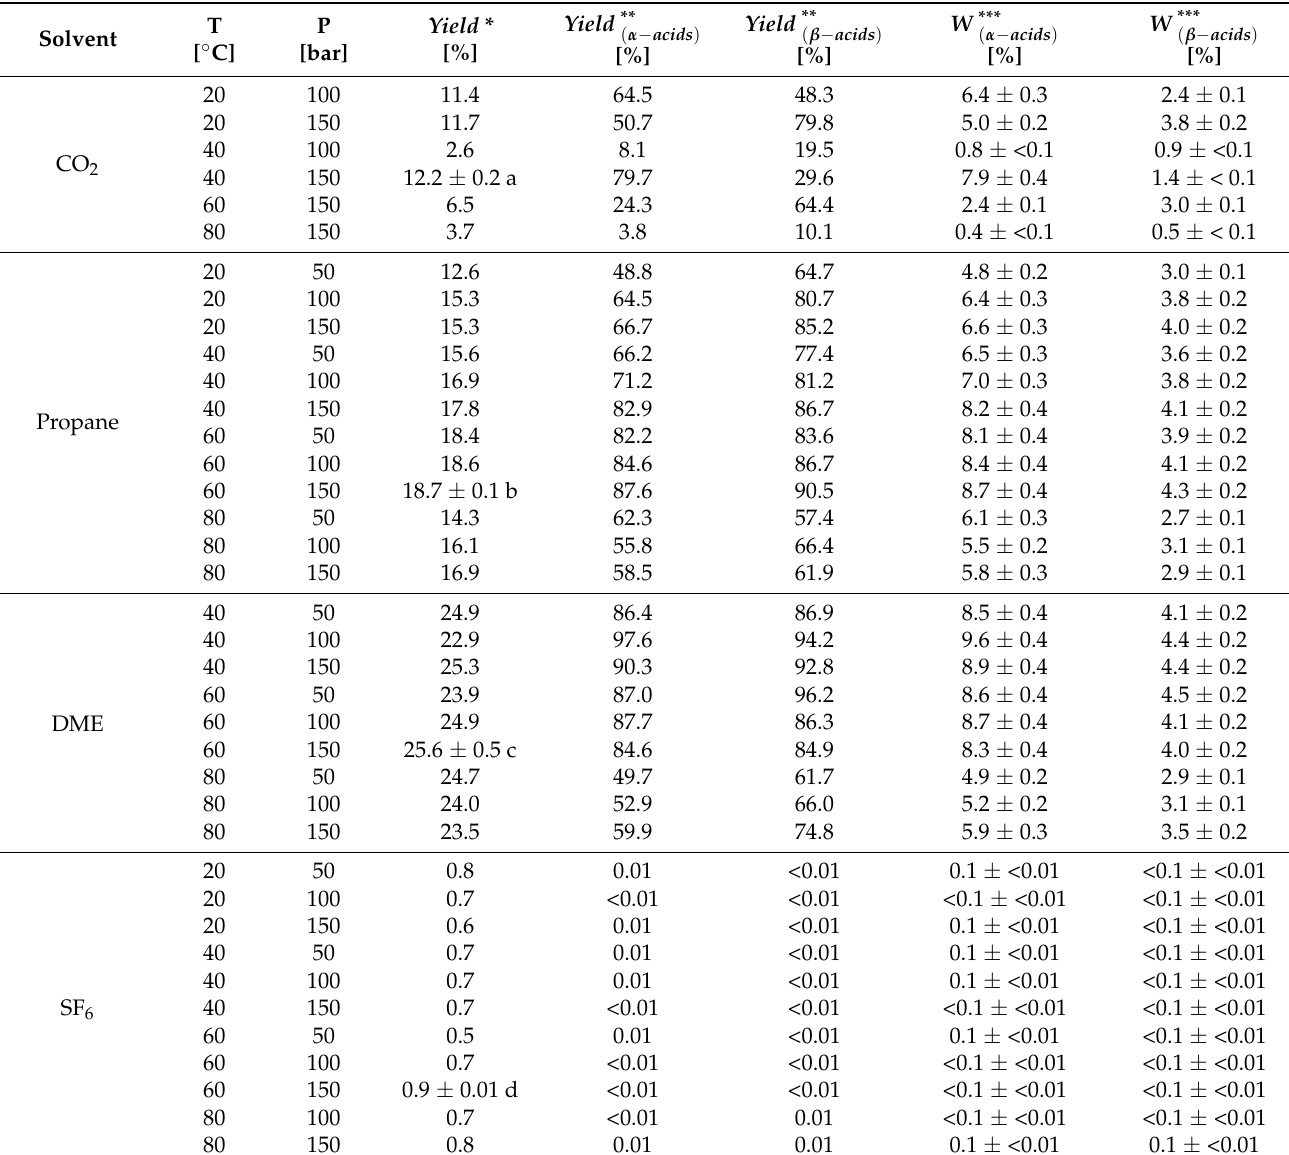
Table 2. Content of α and β -acids in extract expressed in weight % (mean ± SD) and the yield of acids. (Limit of quantification LoQ =